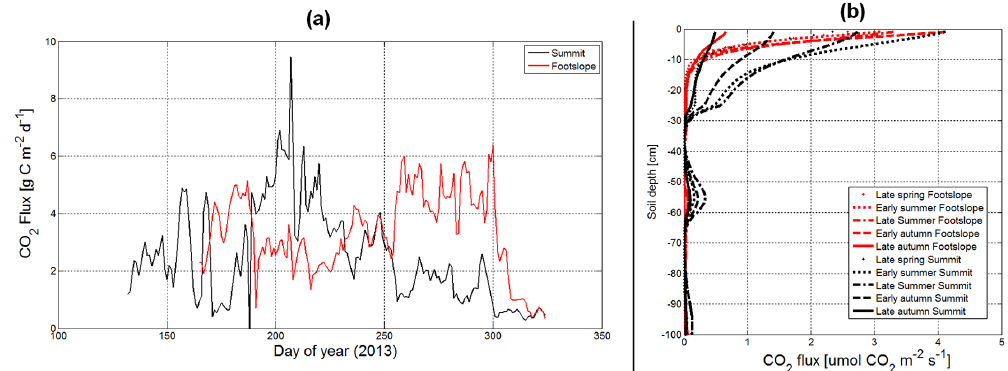
Figure 10. Space-time dynamic of soil CO 2 fluxes,at the summit (red) and the footslope (black) position in 2013: (a) time series at different depths; (b) profile at different dates. The legend of the curves in relation to the different depths and dates is given in Fig. 7. Table 1. Range of standard deviation (SD) and mean values of triplicated measured hourly CO 2 concentrations at each depth, both at the summit and at the footslope position. This range is indicated by minimum (Min) and maximum (Max) values encountered along time (hourly time series) during the 6months measurement period. NI means No Information (i.e. due to a lack of replicates to allow reliable mean and SD). Summit position Footslope position Soil